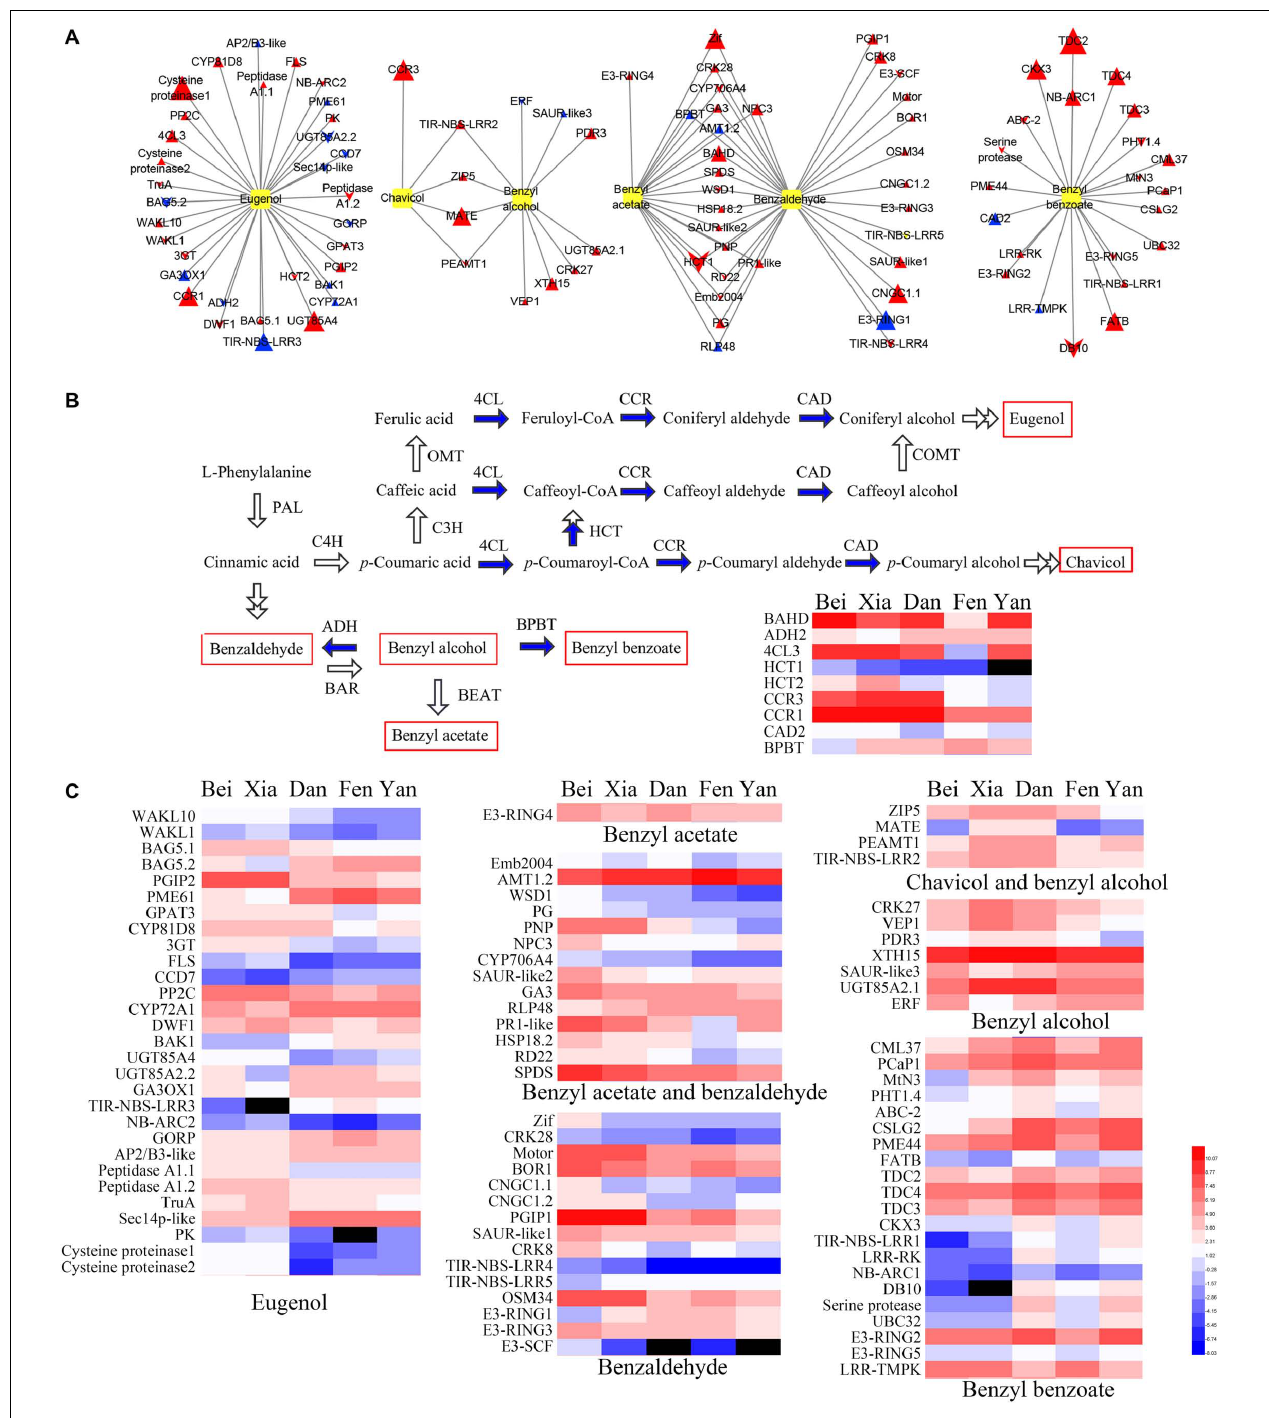
FIGURE 7 | Connections between genes and floral scent metabolites and heat maps of gene expression. (A) The connections between highly associated genes and six metabolites were assessed by correlation analysis. Yellow boxes indicate metabolites. Triangles indicate upregulated genes in blooming flowers, while chevrons indicate downregulated genes in blooming flowers. The sizes of the triangles and chevrons represent the log 2 (fold change) ratios in flowers to buds. Red symbols indicate positive correlations, and blue symbols indicate negative correlations. (B) Biosynthesis pathway and heat maps of the expression of the highly correlated enzyme-coding genes. The blue arrows indicate steps for which the enzyme-coding genes were identified in the correlation analysis. Red rectangles indicate the metabolites detected in intracellular pools. (C) Heat map of the expression of other genes (non-enzyme-coding genes) that were highly correlated with the six metabolites. In the heat maps, the values were normalized by log2 transformation. Red and blue represent high and low transcript expression, respectively. Black represents undetectable expression.